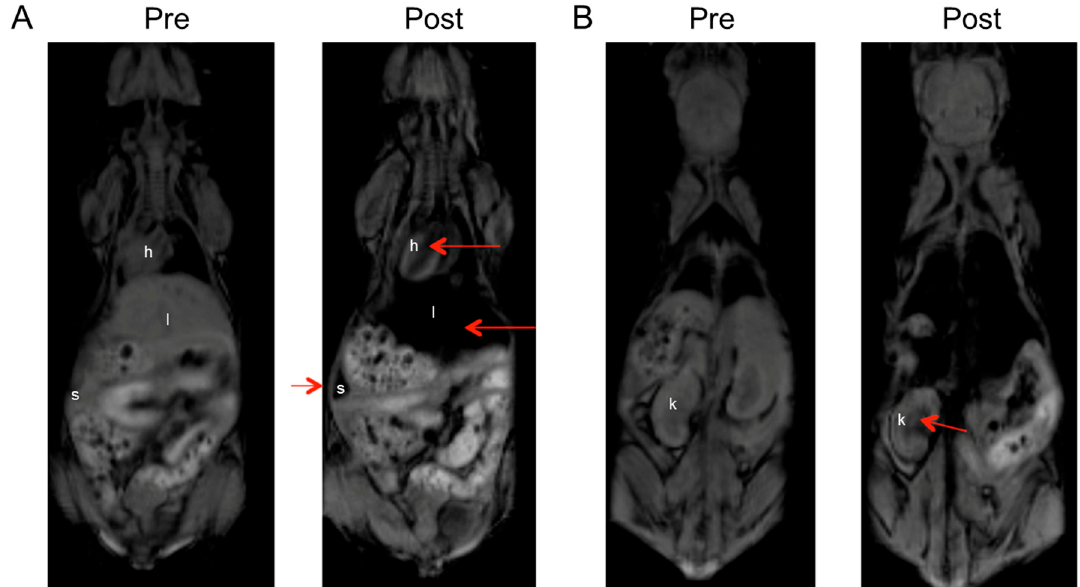
Figure 5. In vivo T1-weighted MRI scans of LHRH-MNPs into non-tumor-bearing nude mice (no tumors), showing darkening effect. ( A ) Image slice depth highlighting liver (l), heart (h) and spleen (s). ( B ) Image slice depth highlighting kidney (k).